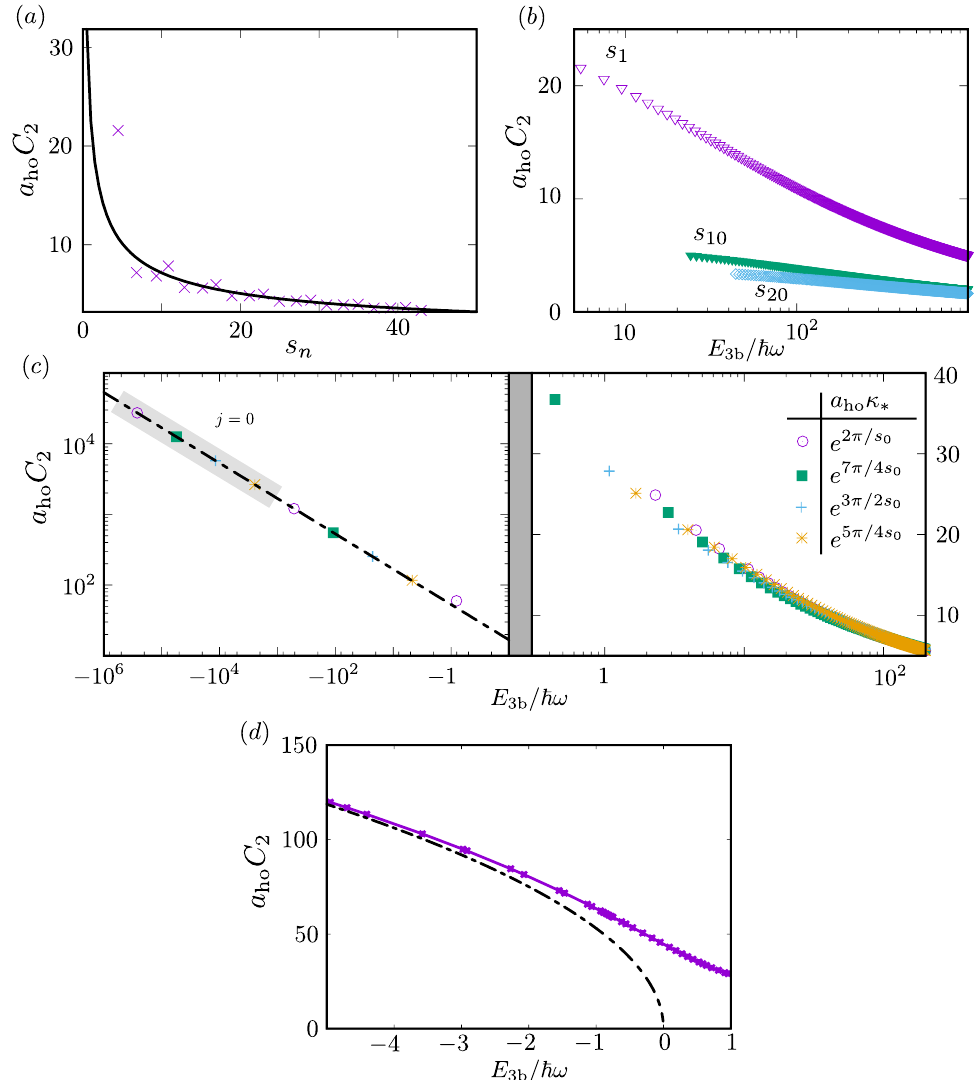
Figure 2. Behavior of a ho C 2 for both negative and positive eigenenergies in the universal and Efimov ( s ,0 ) channels. ( a ) The behavior of a ho C for s 2 > 0 compared against the s → + ∞ asymptotic result 2 ( s , j ) (black solid line) Equation (54); ( b ) results for a ho C for s 2 > 0 over a range of energies in the three 2 ( s 0 , j ) universal channels s 1 ≈ 4.465, s 10 ≈ 22.932, and s 20 ≈ 42.967; ( c ) results for a ho C for four values 2 of a ho κ ∗ chosen evenly spaced over a single log-period (same as in Figure 1) as indicated in the key. The black dashed-dotted line is the asymptotic result for a ho C 2 in the limit E 3b /¯ h ω → − ∞ given by Equation (51). The grey shaded region indicates the j = 0 eigenstates; ( d ) the transition of a ho C s 0 , j as a 2 function of E 3b /¯ h ω from positive to negative energies. The black dashed-dotted line is the same as in ( c